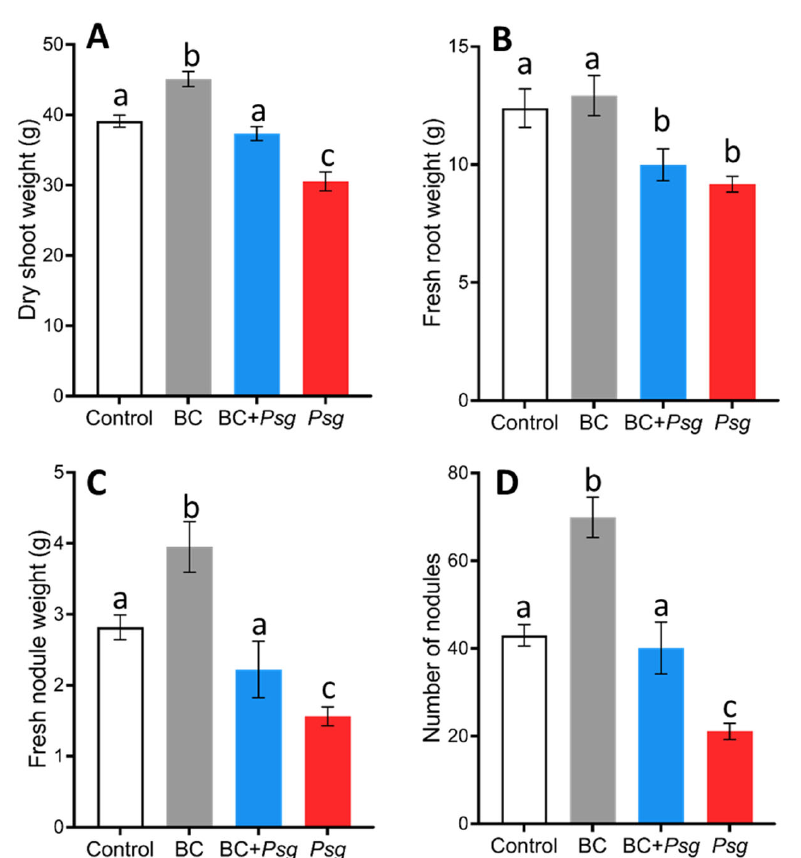
Figure 3. ( A − D ) . Variations in mean soybean plant growth parameters, including dry shoot weight ( A ), fresh root weight ( B ), fresh nodule weight ( C ), and the number of nodules ( D ) across four different treatment groups on day 35 of plant growth. Treatment had a significant effect on dry shoot (F = 30.77; p < 0.0005) and fresh root weights (F = 7.4; p < 0.0005). For both dry shoot and fresh root weight 20 plants per treatment were measured. The nodule weight (F = 12.30; p < 0.0005) and the number of nodules (F = 24.95; p < 0.0005) per plant were also different. We collected 10 root nodules per plant from 10 randomly selected plants for each treatment and were analyzed for fresh nodule weight. The treatments that do not share the same letter are significantly different (alpha = 0.05, Tukey-adjusted). Error bars represent the standard error of the mean. Bacterial consortium (BC).